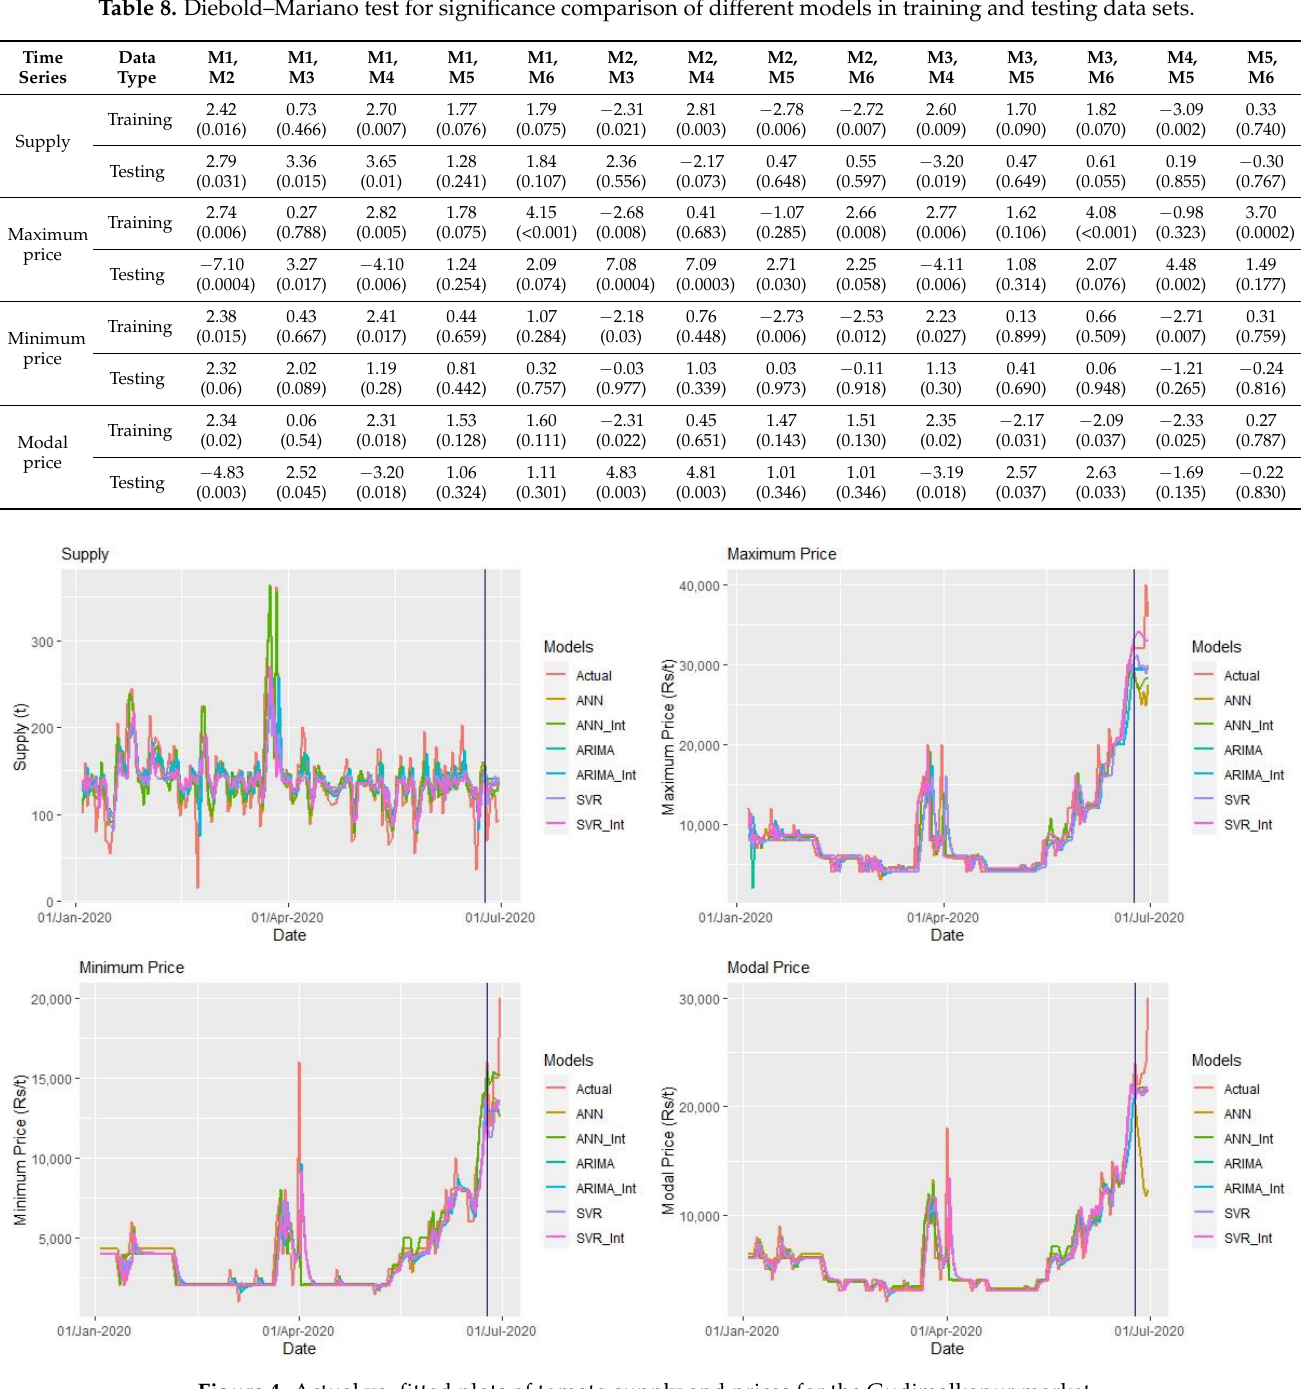
Figure 4. Actual vs. fitted plots of tomato supply and prices for the Gudimalkapur market.